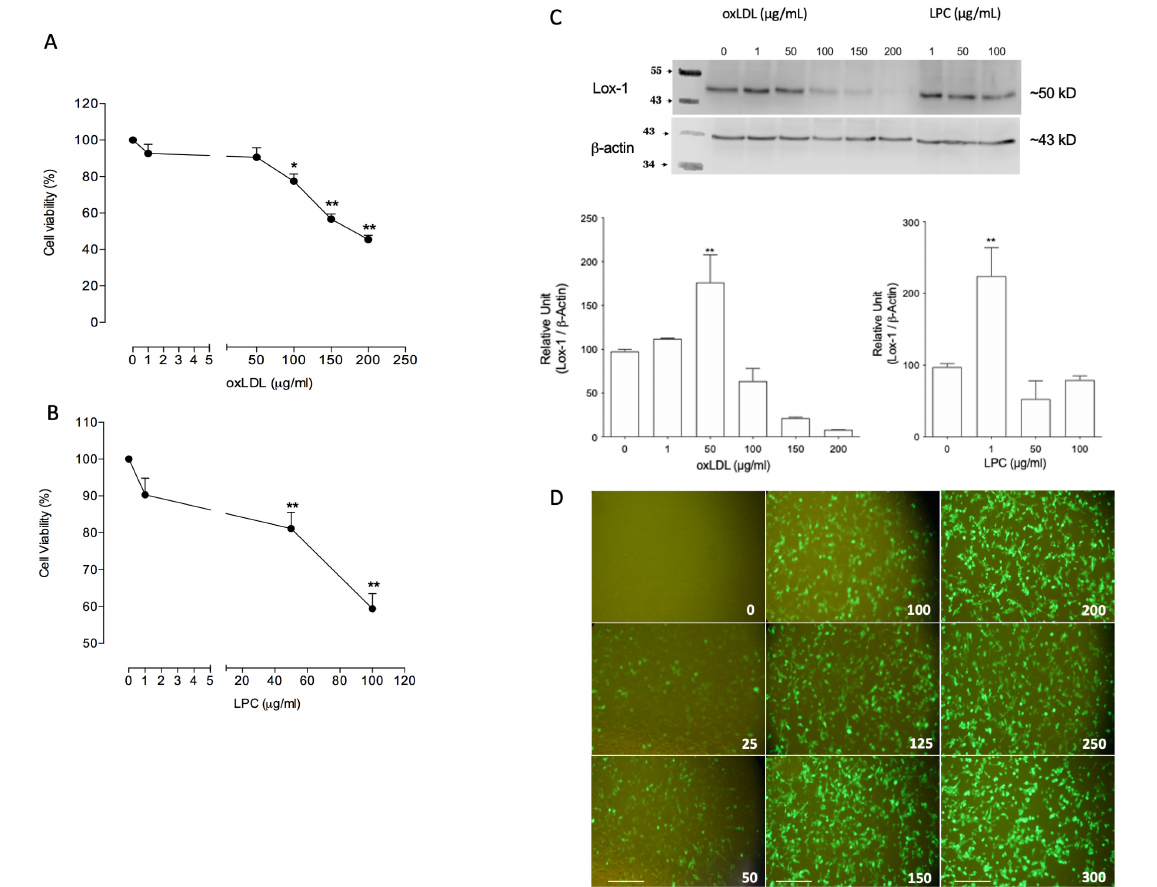
Figure 1. Ox-LDL and LPC induce Lox-1 expression and cytotoxicity in H4-II-E-C3 cells. Determination of cytotoxicity by Oxidized low-density lipoprotein, (ox-LDL) ( A ) or Lysophosphatidylcholine (LPC) ( B ) by incorporating ethidium homodimer-1 in H4-II-E-C3 cells. ( C ) Western blot was carried out with a specific antibody for checking the Lox-1 protein in H4-II-E-C3 cells after treatment with LPC and ox-LDL. β -Actin was used as a loading control for normalization. ( D ) The representative motive of infection (MOI) for the adenoviral vectors Ado-LOXIN in H4-II-E-C3 cells. Values are expressed as mean and SEM ( n = 4). Scale bars indicate 200 μ m. * p <0.05 and ** p <0.01 versus to control cells.